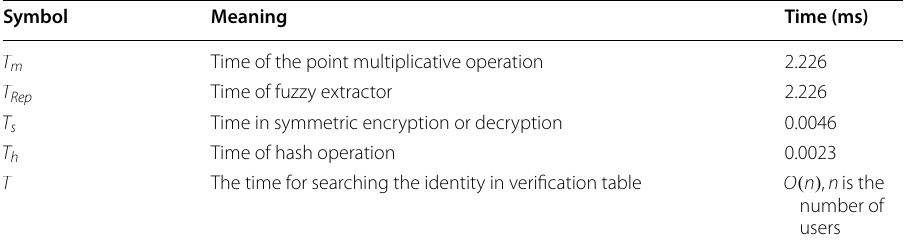
Table 6 Notations of time symbols Symbol